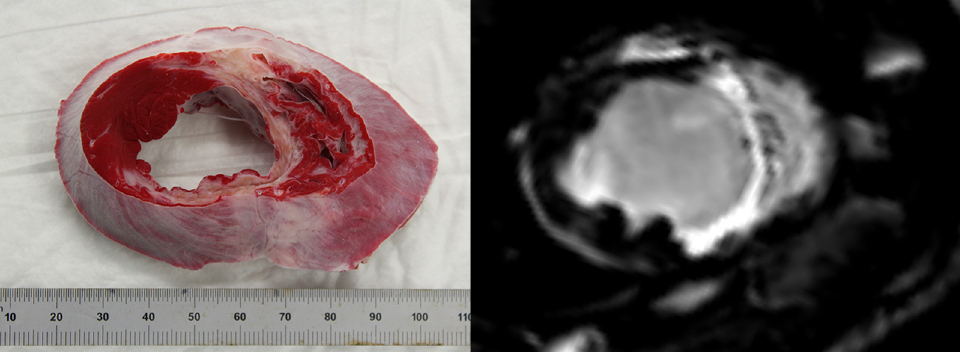
Fig 5. Infarct size. Representative pictures of TTC stained heart slice and LGE image of the same animal. Mean ( ± SD) infarct size of CMPC and placebo animals were 14.6 ± 2,5% and 13.8 ± 3.9% of the left ventricle based on TTC staining and 17.5 ± 3.8 and 18.0 ± 4.5 based on LGE imaging.